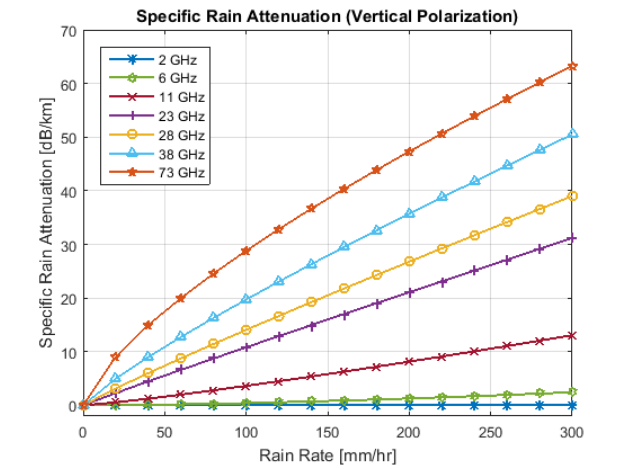
Fig 32. Specific Rain Attenuation (Vertical Polarization)